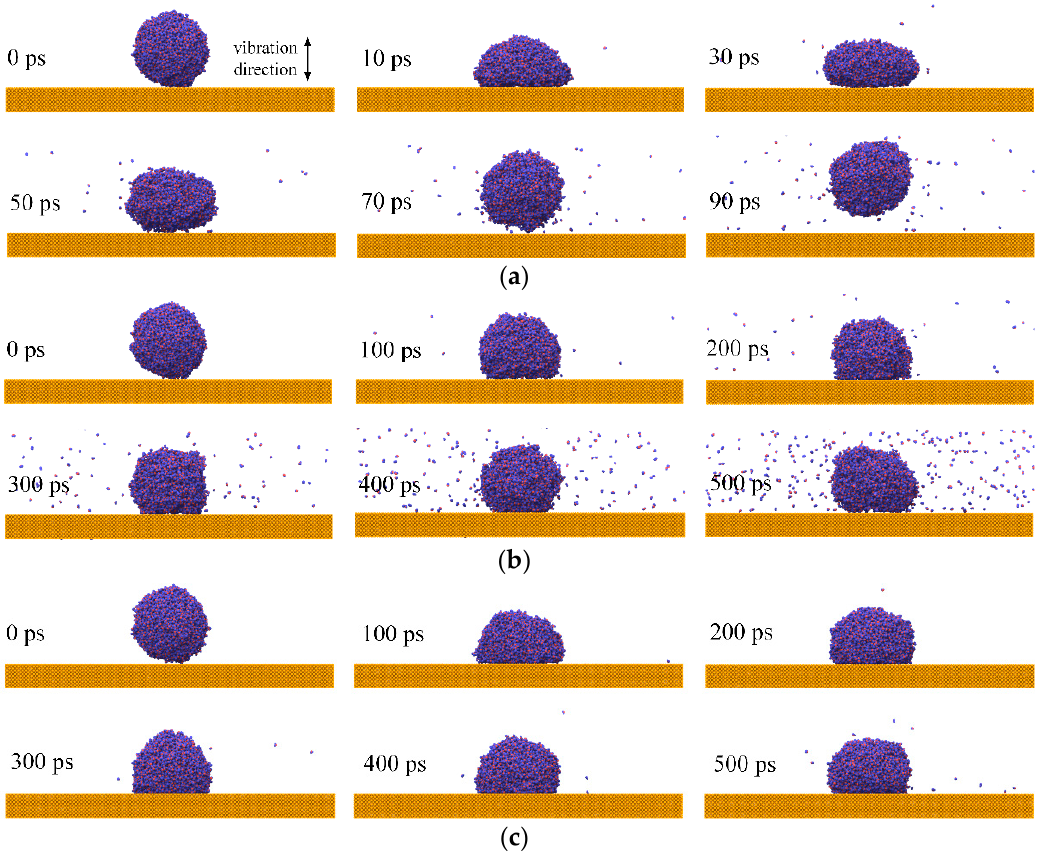
Figure 15. Dynamical behaviors of water nanodroplets impinging on surfaces with different vibration periods: ( a ) T = 2 ps; ( b ) T = 8 ps; ( c ) T = 16 ps. The variation in centroid height h for water nanodroplets is shown in Figure 16.